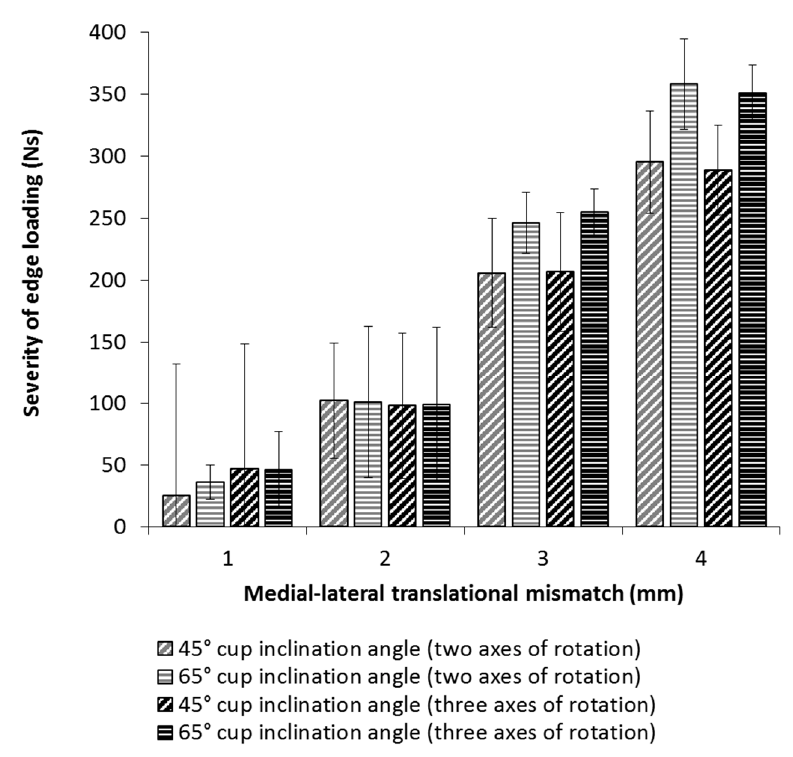
Figure 6. Severity of edge loading (mean ± 95% confidence limits, n = 3) of 36 mm diameter BIOLOX ® delta ceramic-on-ceramic bearings under two axes and three axes of rotation conditions with 45° and 65° cup inclination angles and 1, 2, 3 and 4 mm of medial-lateral translational mismatch conditions (offset deficiency).